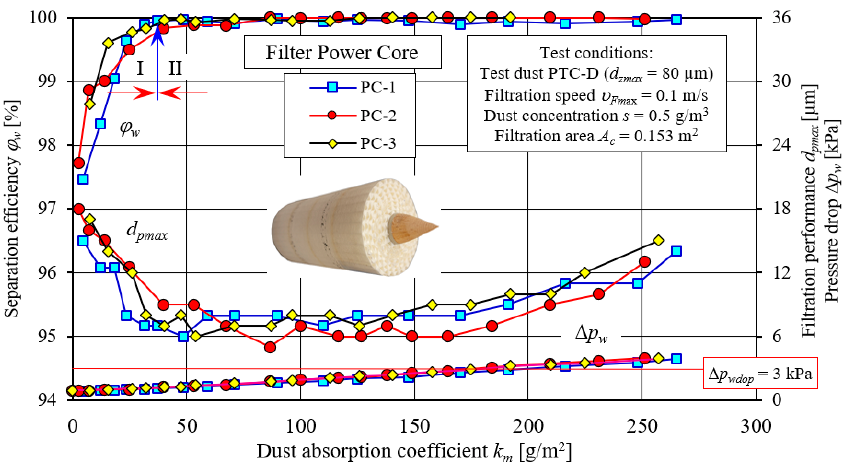
Figure 16. Characteristics of separation efficiency ( φ w ) and filtration performance ( d pmax ) and pressure drop ( Δ p w ) depending on the dust absorption coefficient ( k m ) of three test specimens of PowerCore-PC filter cartridges.